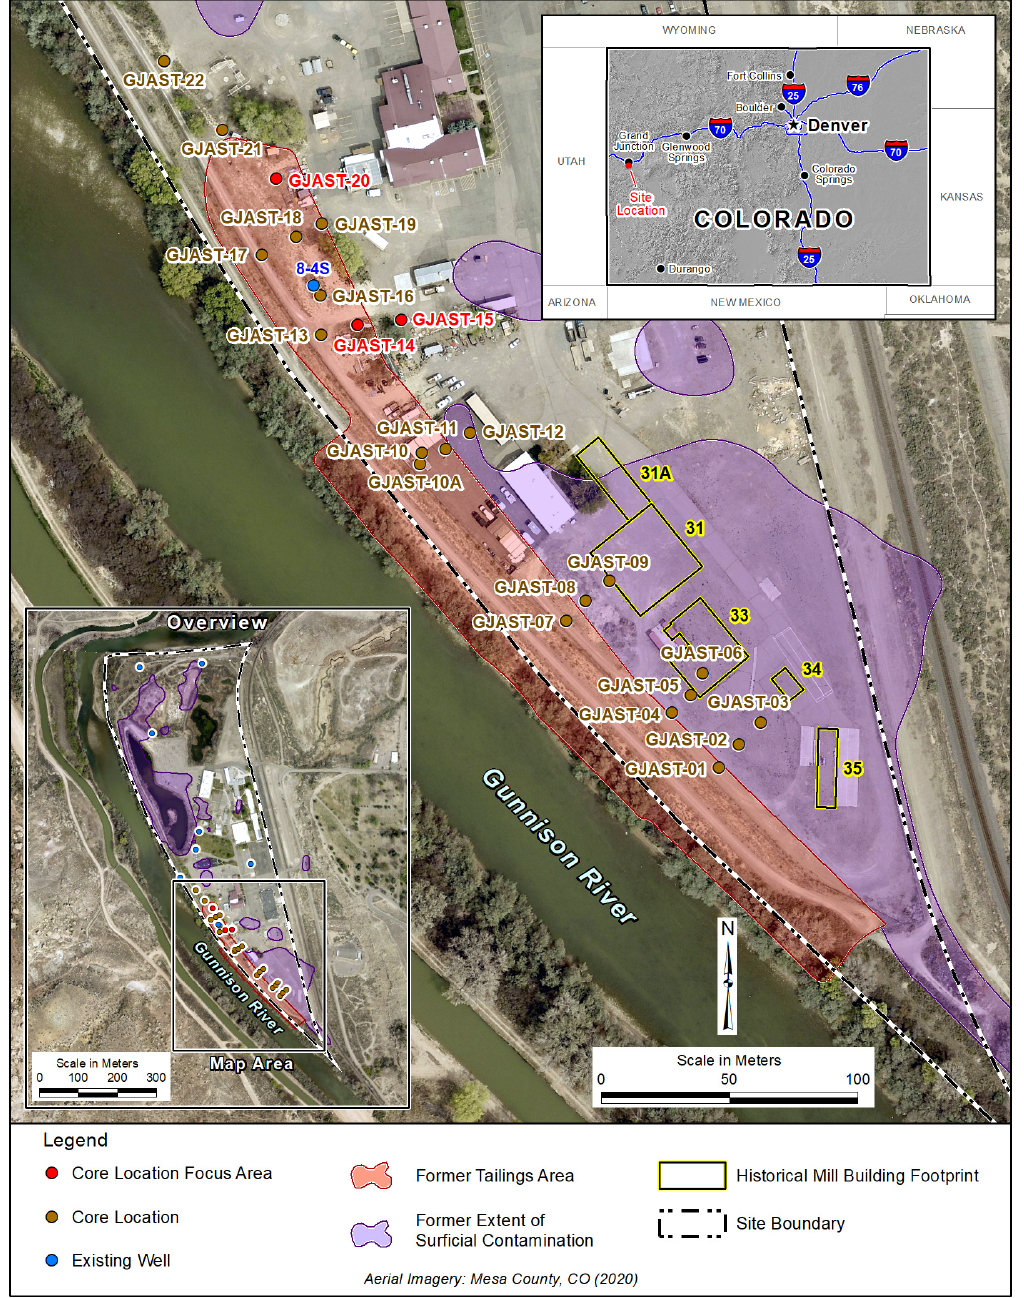
Figure 1. GJO site map with coring locations [1] and former tailings area [10].